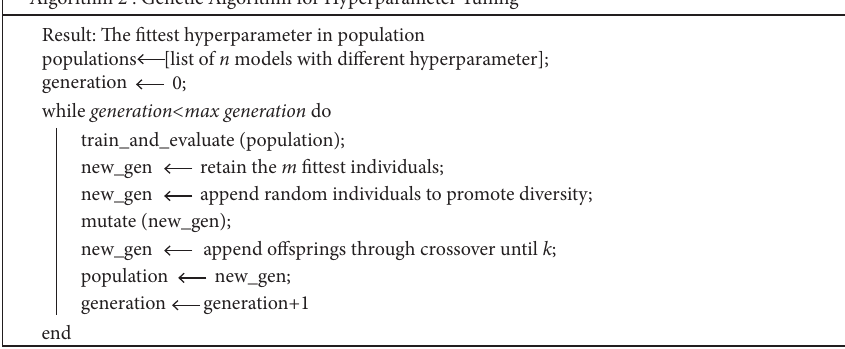
Algorithm 2 : Genetic Algorithm for Hyperparameter Tuning